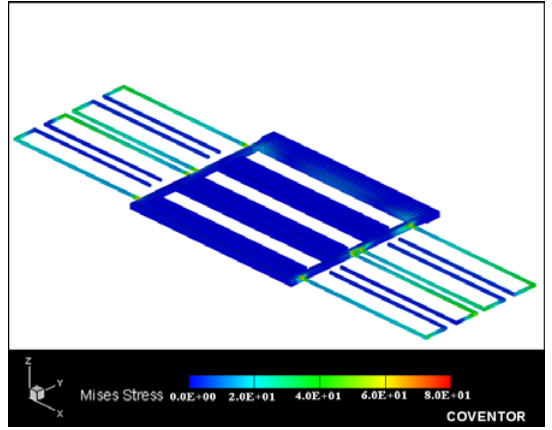
Figure 7. Stress distribution of the resonator.